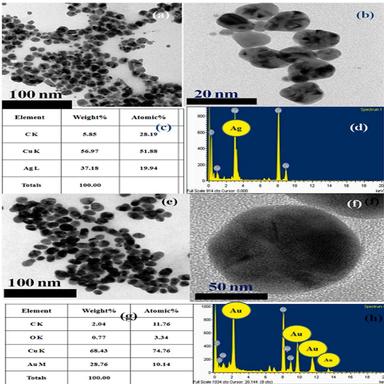
(a–b) TEM imagesof (a-b), atomic %, (c), EDAX (d) of Ag-NPs. TEM images (e–f), atomic % (g) and EDAX (h) of Au-NPs.